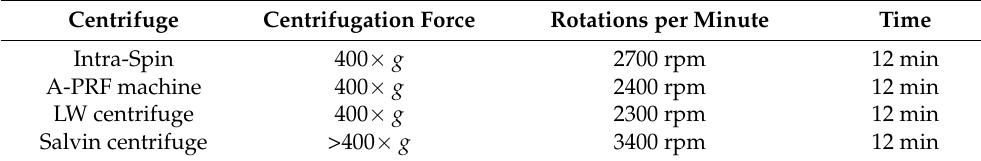
Table 5. Centrifuges and centrifugation parameters used to prepare L-PRF